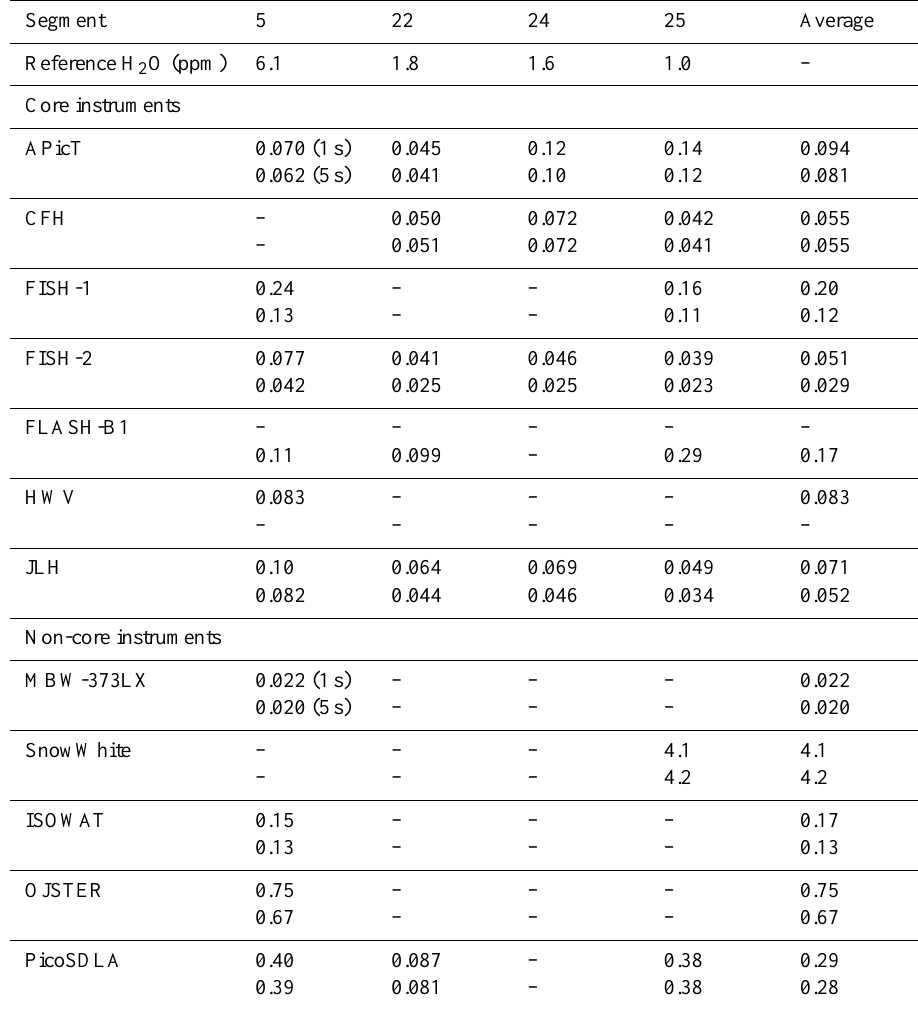
Table 4. Experimental upper limits of instrument precision derived from the AquaVIT-1 intercomparison data for selected segments during the static experiments a